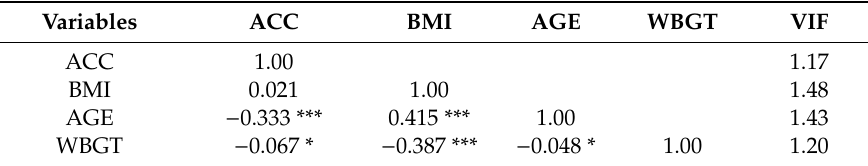
Table 4. Descriptive statistics and correlation matrix for workers’